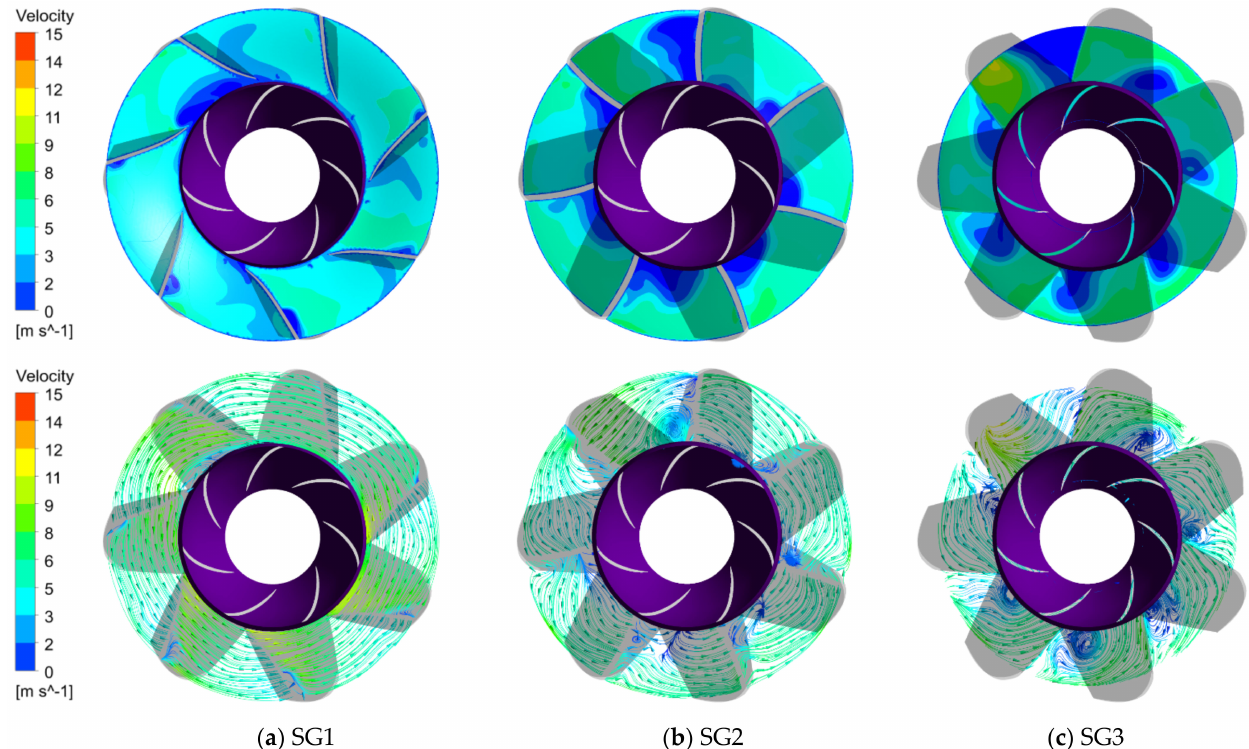
Figure 15. Flow axial velocity contours and streamlines within the diffuser under 0.92 Q BEP flow conditions for different positions along the streamwise